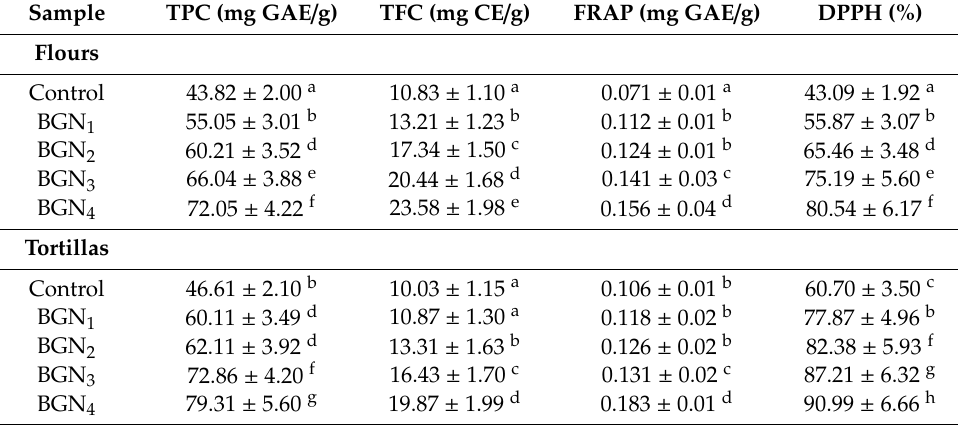
Table 3. Polyphenolic compounds and antioxidant activity of composite flours and tortillas. Sample